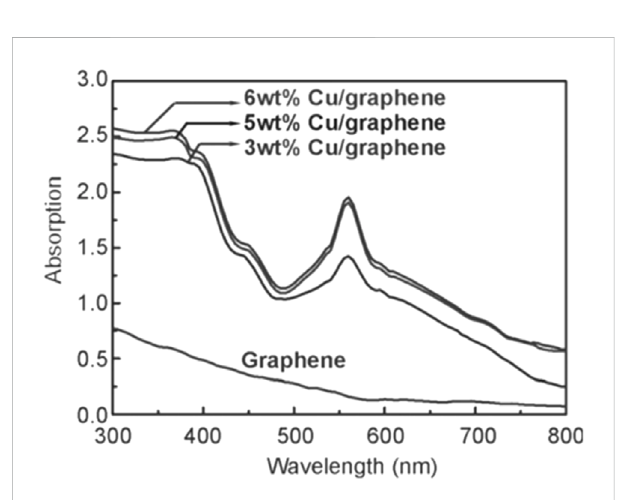
FIGURE 14 UV-vis absorption spectra of Cu/graphene photocatalysts. Reproduced with permission from reference (Guo et al.,